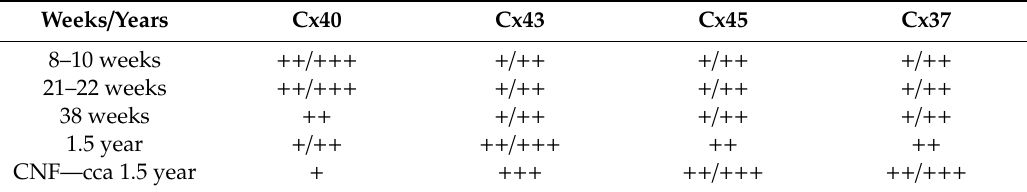
Table 1. Expression of di ff erent Cxs in the JGA of developing kidneys, postnatal healthy and CNF